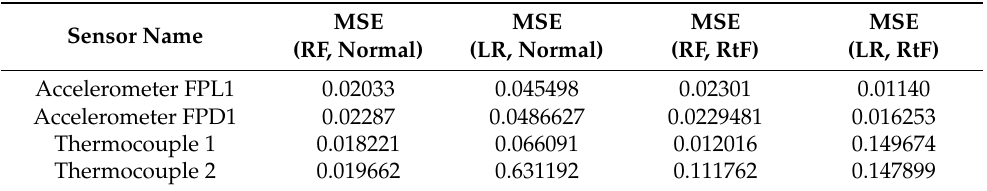
Table 8. Mean square error result comparison between RF regression and linear regression in normal and run-to-fail (RtF) methods in the sample thermocouple and